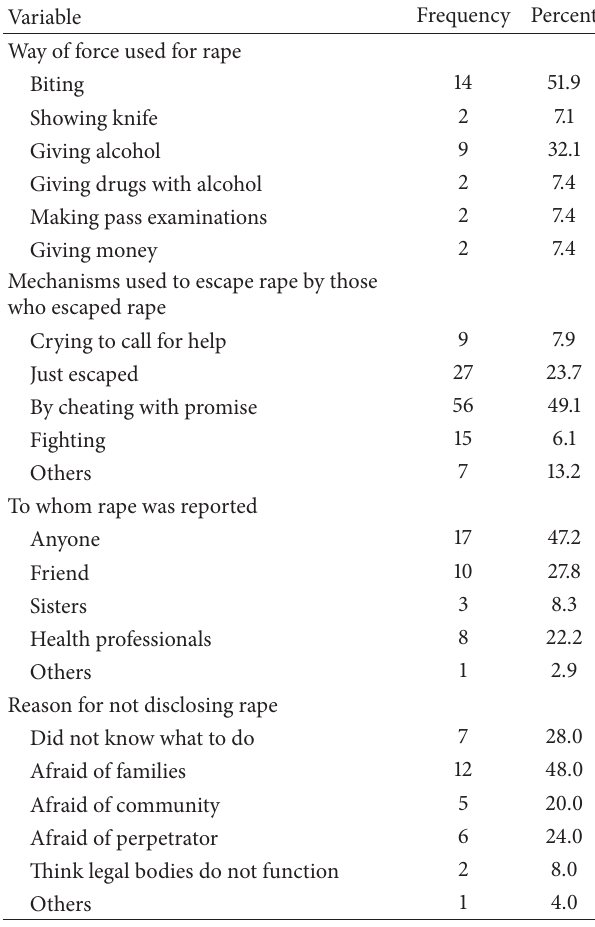
Table 5: Ways of raping, mechanism used to escape, to whom rape was reported, and reason for not reporting rape, Madawalabu University, May